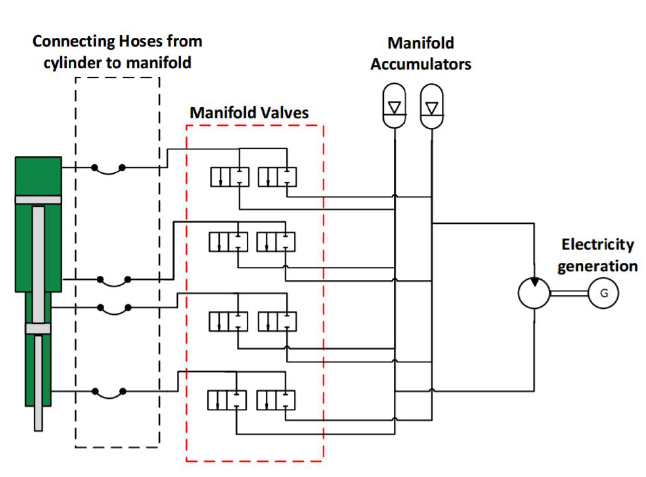
Figure 4. The layout of the Discrete Displacement Cylinder (DDC) hydraulic